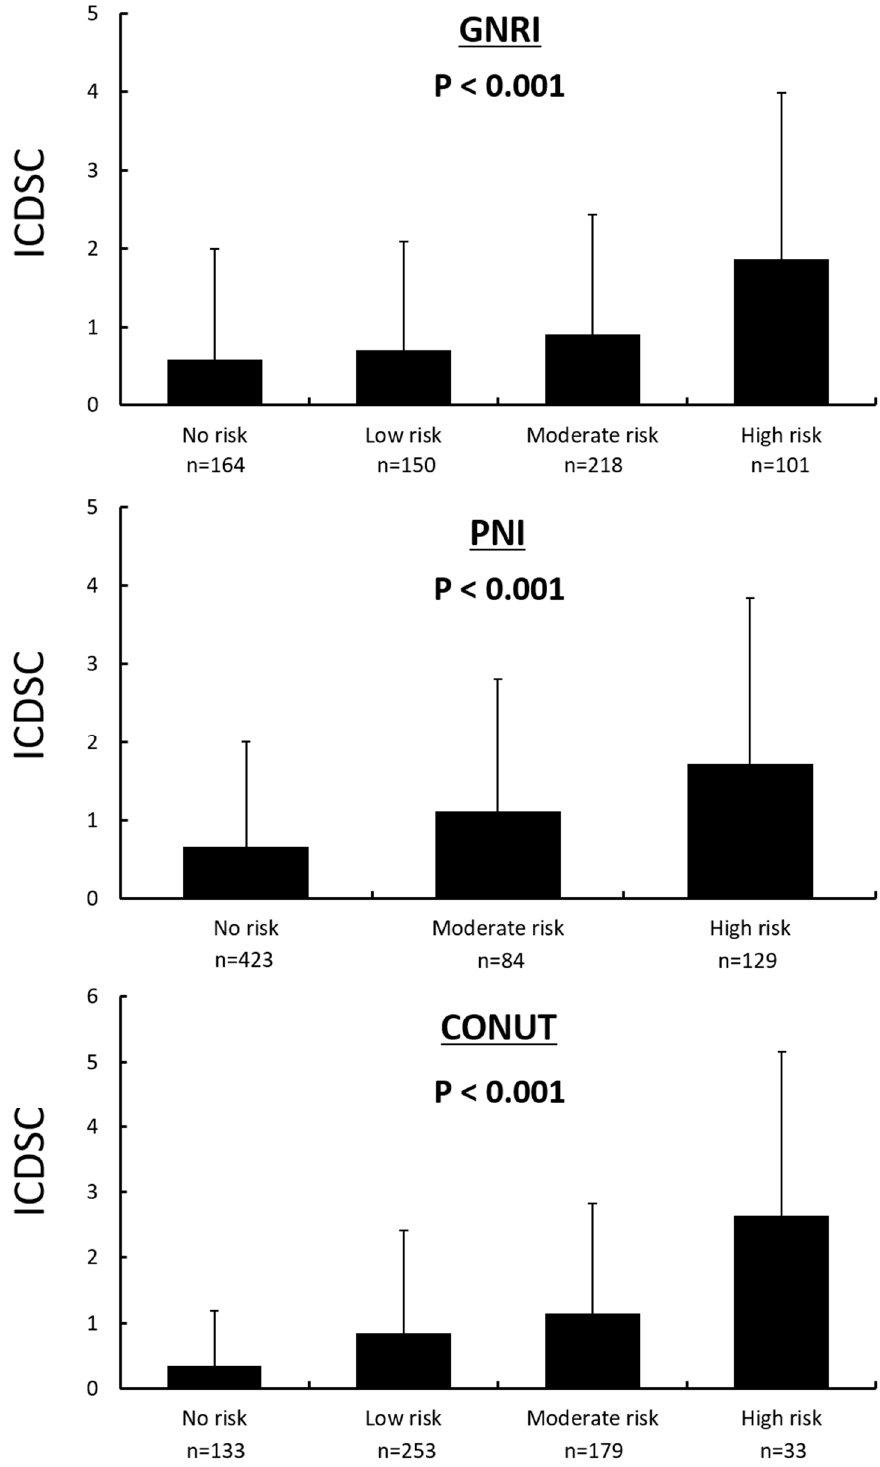
Figure 2. A comparison of the delirium scores of patients with different nutritional status on admission. The delirium score (ICDSC, Intensive Care Delirium Screening Checklist) increased progressively from the no-risk to the high-risk category, as assessed by each nutritional index. Data are presented as mean ± standard deviation.